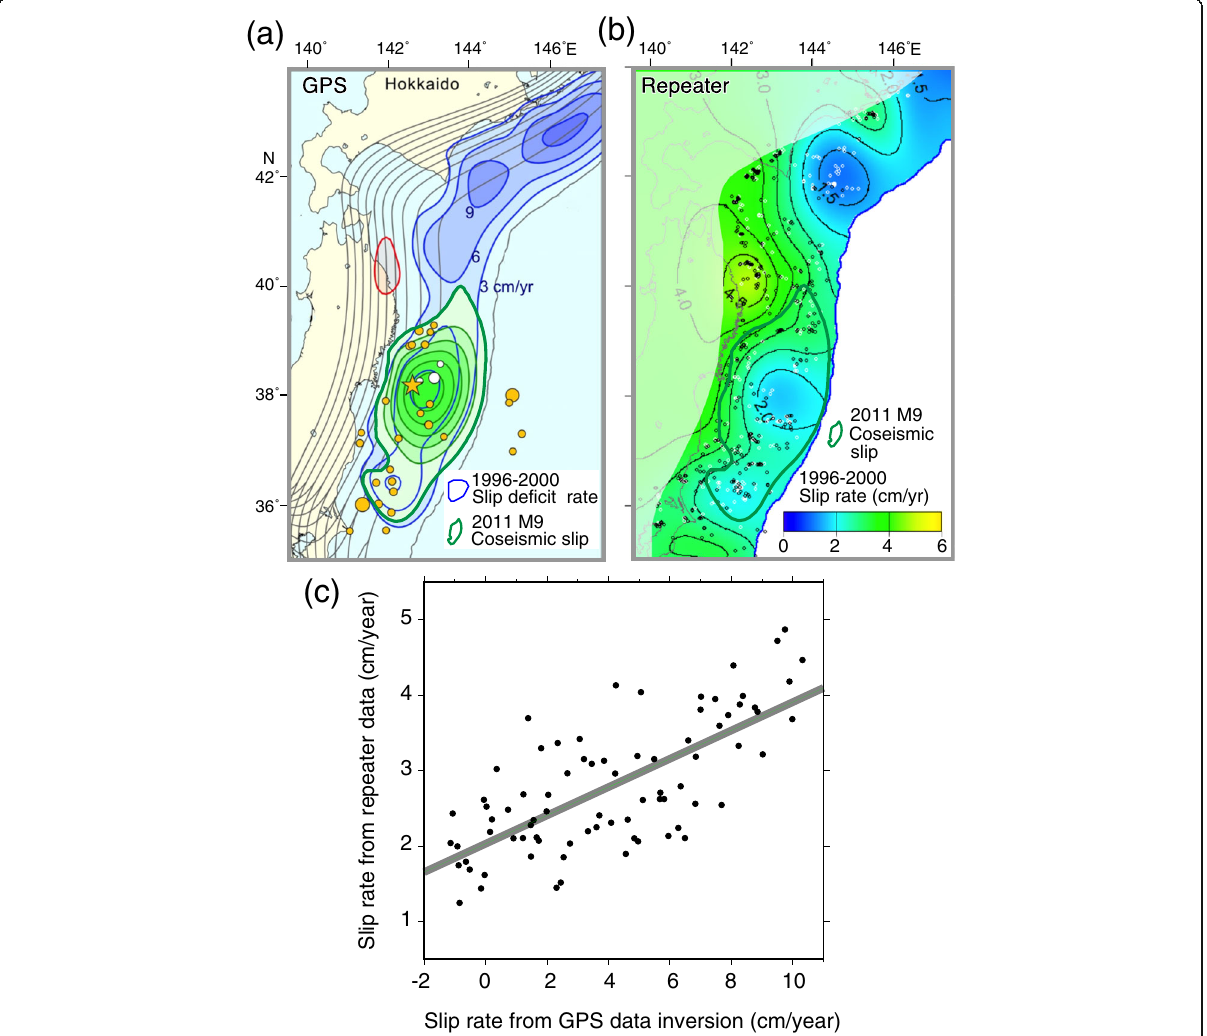
Fig. 15 Relationship between slip rate estimated from GPS (Hashimoto et al. 2012) and repeating earthquakes (Nomura et al. 2017) in the Tohoku subduction zone for the period from 1996 to 2000 (modified from Nomura et al. (2017)). a shows the spatial distribution of GPS slip deficit/excess rate by Hashimoto et al. (2012) and b displays the repeater-derived slip rate for the period of 1996 – 2000 for comparison. The contour interval for the slip deficit is 3 cm/year. Green contours in a show the coseismic slip distribution of the 2011 Tohoku-oki earthquake (M9) at a contour interval of 4 m. Orange star shows the epicenter of the Tohoku-oki earthquake. White and orange circles show foreshocks on March 9 and the aftershocks for March 11 – 14, respectively. The thin black contours represent depth to plates in 10 km interval. The black and white circles in b represent repeating earthquakes within and outside the 1996 – 2000 time period, respectively. The slip rate at 60-km-depth or larger is masked since there are almost no data constraints. Thick green line is 4 m coseismic slip shown in a . c Slip deficit rates at ~ 50 km grid points on the plate interface shallower than 80 km are sampled and converted to slip rate by assuming a plate convergence rate of 8.5 cm/year. The straight gray line (slope = 0.19, intercept = 2.0) indicates the least-squares fit to the